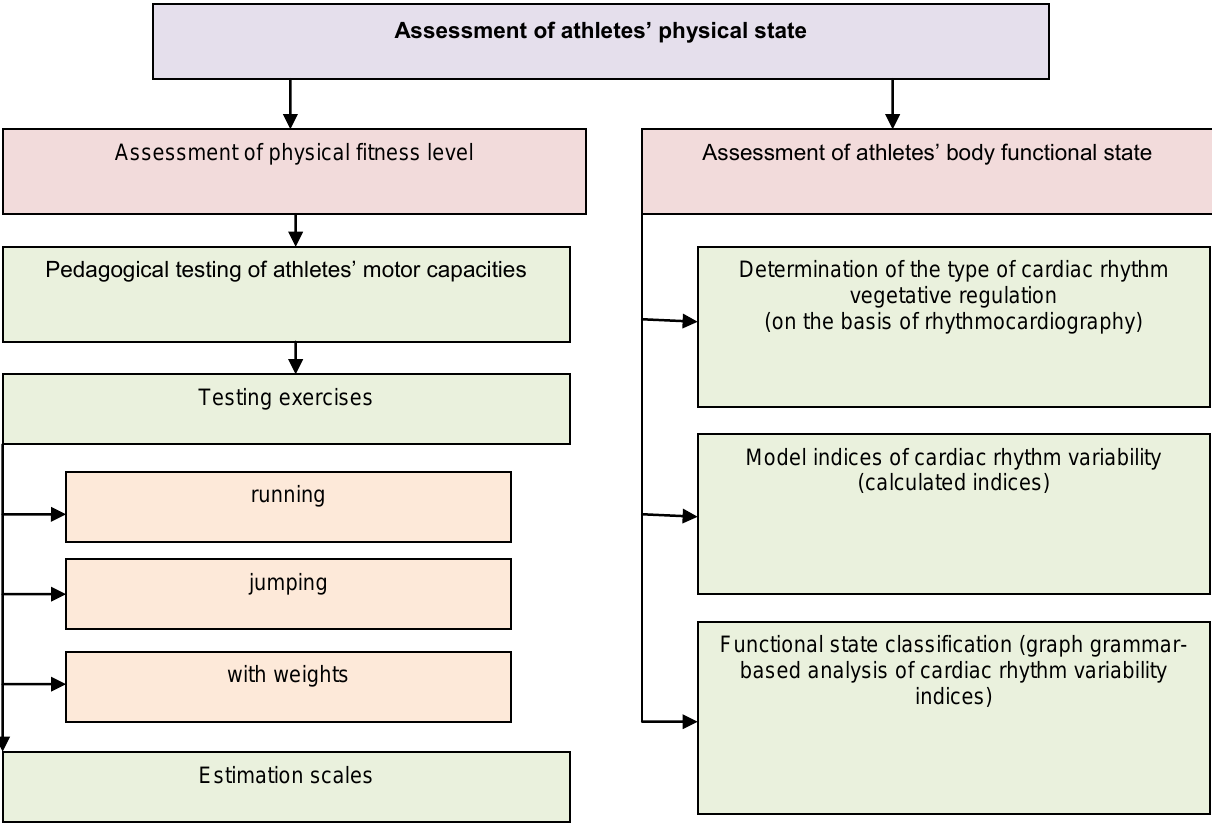
Fig. 3. Diagram of the methods of estimating physical state of skilled track and field athletes – members of reserve national team of